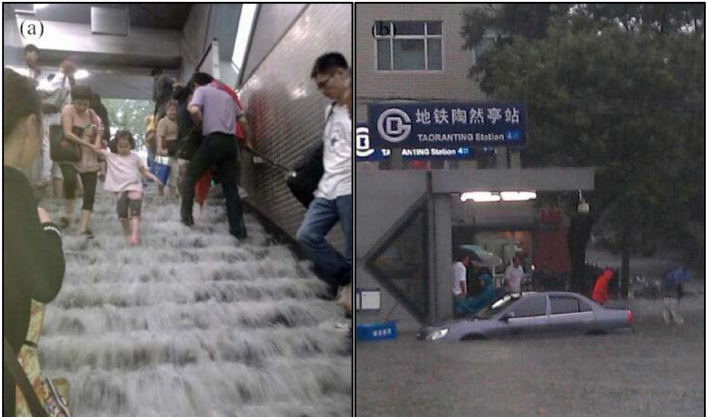
Figure 1. The Beijing subway station was flooded during heavy rainfall on 23 June 2011. ( a ) Flood- water entered into the southwest exit (Exit D) of the Taoranting station along the escalator. ( b ) Road waterlogging outside the Taoranting subway station (Exit